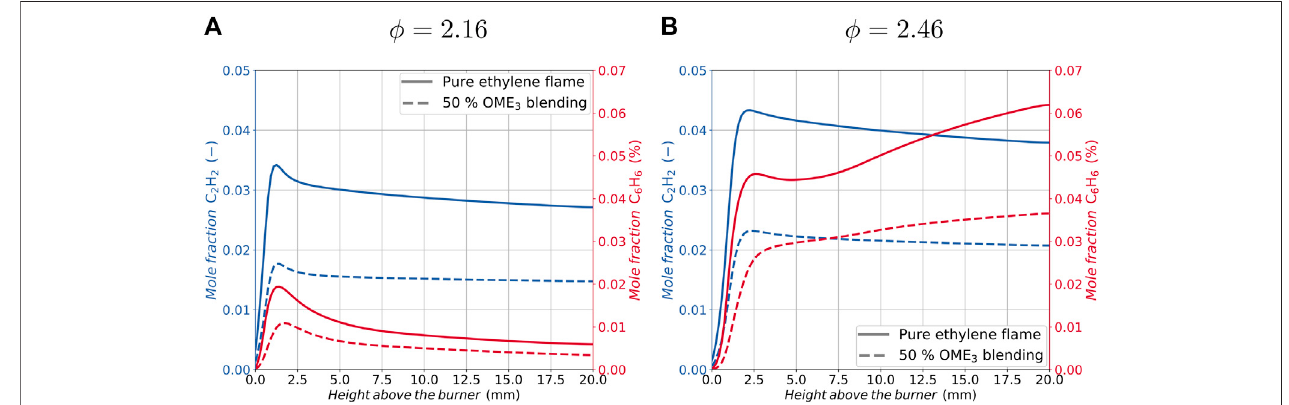
FIGURE 2 | Species mole fraction pro fi les of acetylene (C 2 H 2 , blue lines) and benzene (C 6 H 6 , red lines) as a function of the height above the burner with an equivalence ratio of ϕ (cid:1) 2.16 (A) and ϕ (cid:1) 2.46 (B) for pure ethylene fl ames (solid lines) and 50% OME 3 blending ratio (dashed lines).